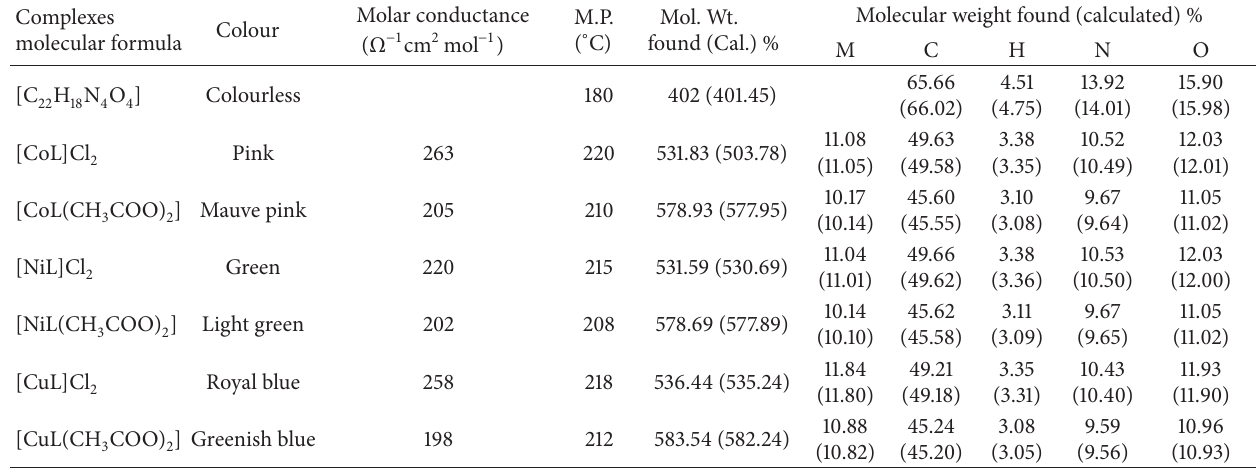
Table 2: Analytical data and physical properties of the ligand and complexes. Complexes